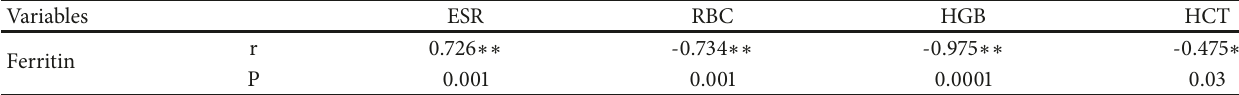
Table 4: Correlation between serum ferritin and iron statuses in RA